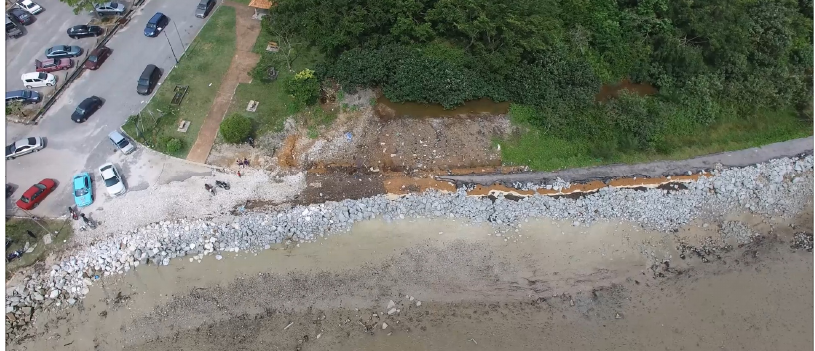
Figure 10. Facilities damage impacts on shoreline changes in Pantai Kelanang.